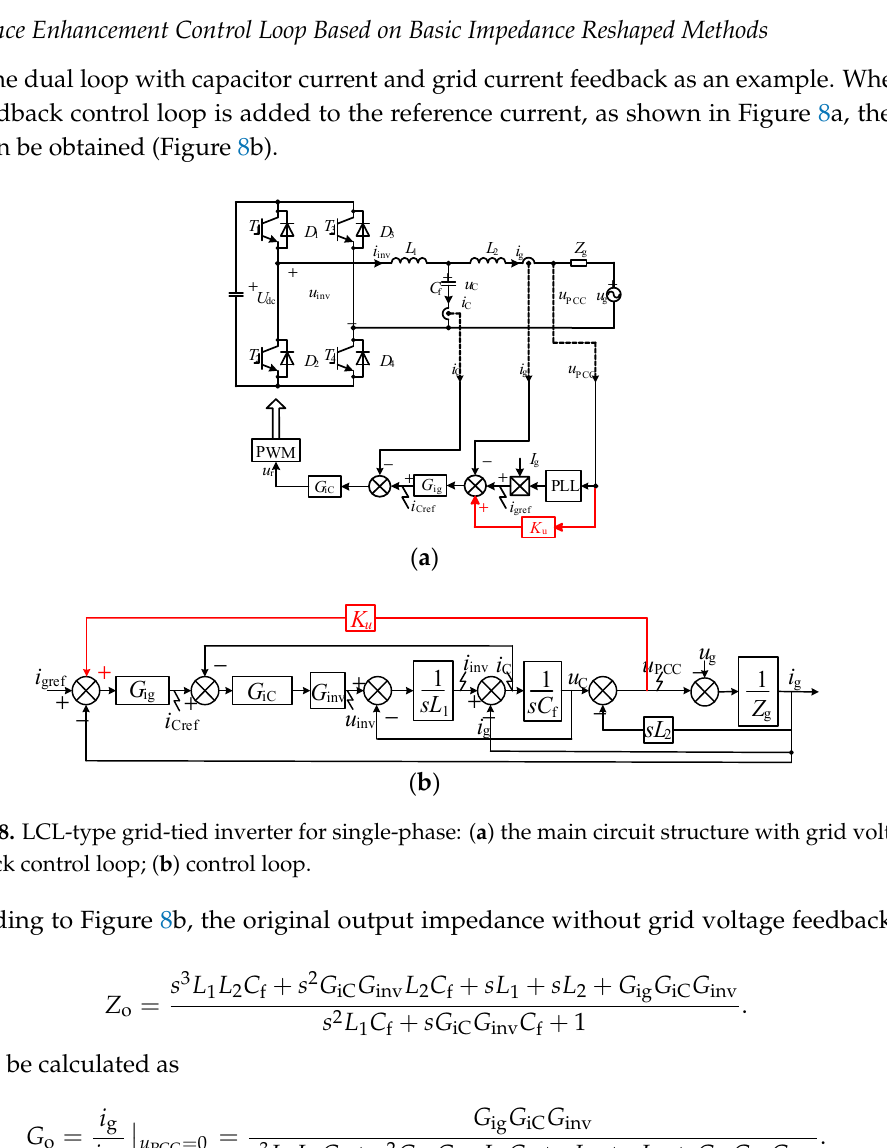
Z oi Z ou 70 Figure 7. Bode plots of output impedance with two basic impedance reshaped methods.